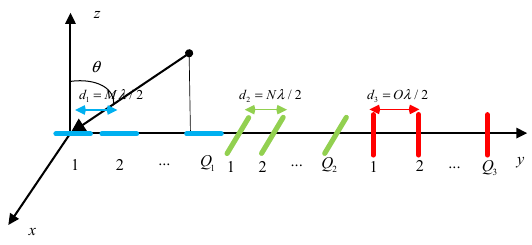
Figure 1. Data model of triple coprime array.